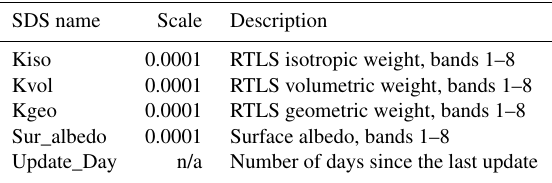
Table 4. Eight-day BRDF model parameters (MCD19A3).